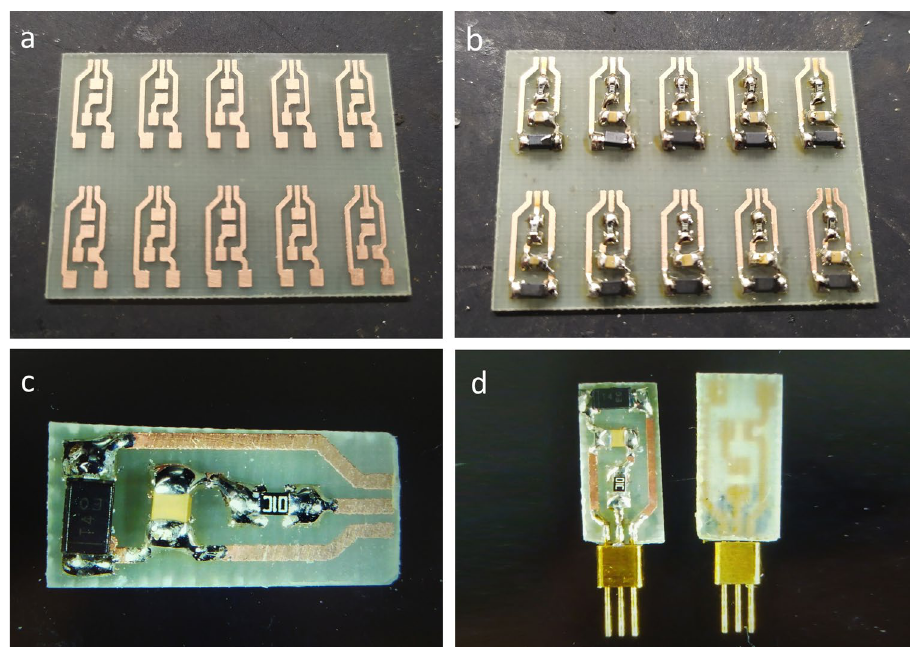
Figure 1. Fabrication of the printed circuit boards; ( a ) unpopulated board; ( b ) populated board; ( c ) detail of a depanelized board; ( d ) hermetic feedthrough soldered to the